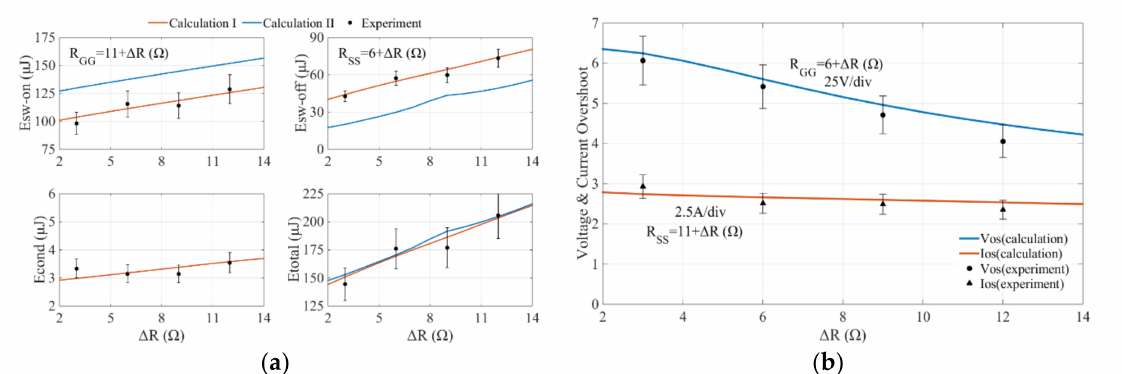
Figure 13. Comparison between experiment and calculation under the influence of external driver resistance R g . ( a ) Power losses. ( b ) Voltage overshoot and current overshoot.